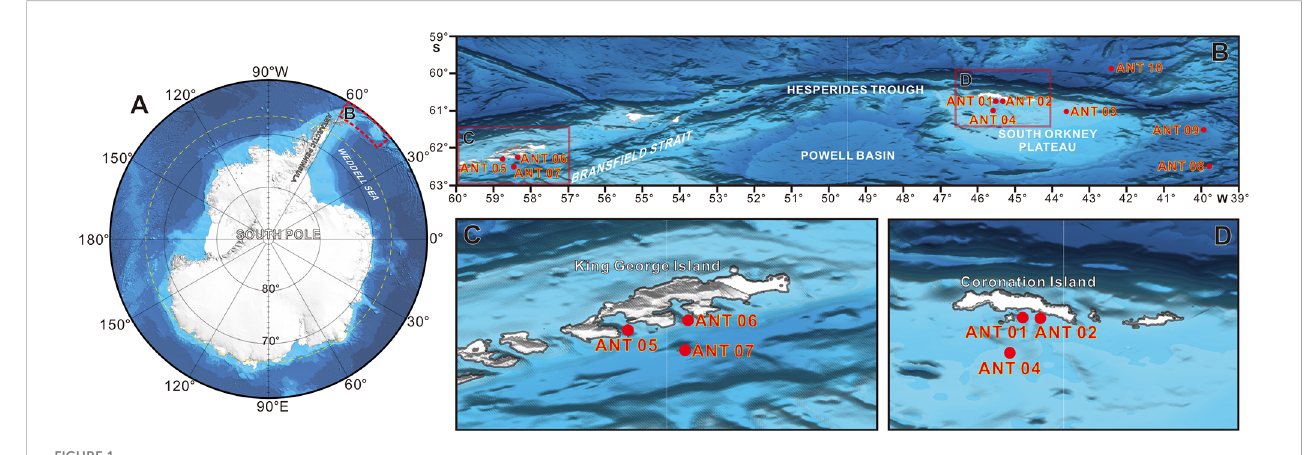
FIGURE 1 Location of the ten sampling sites in the Antarctic